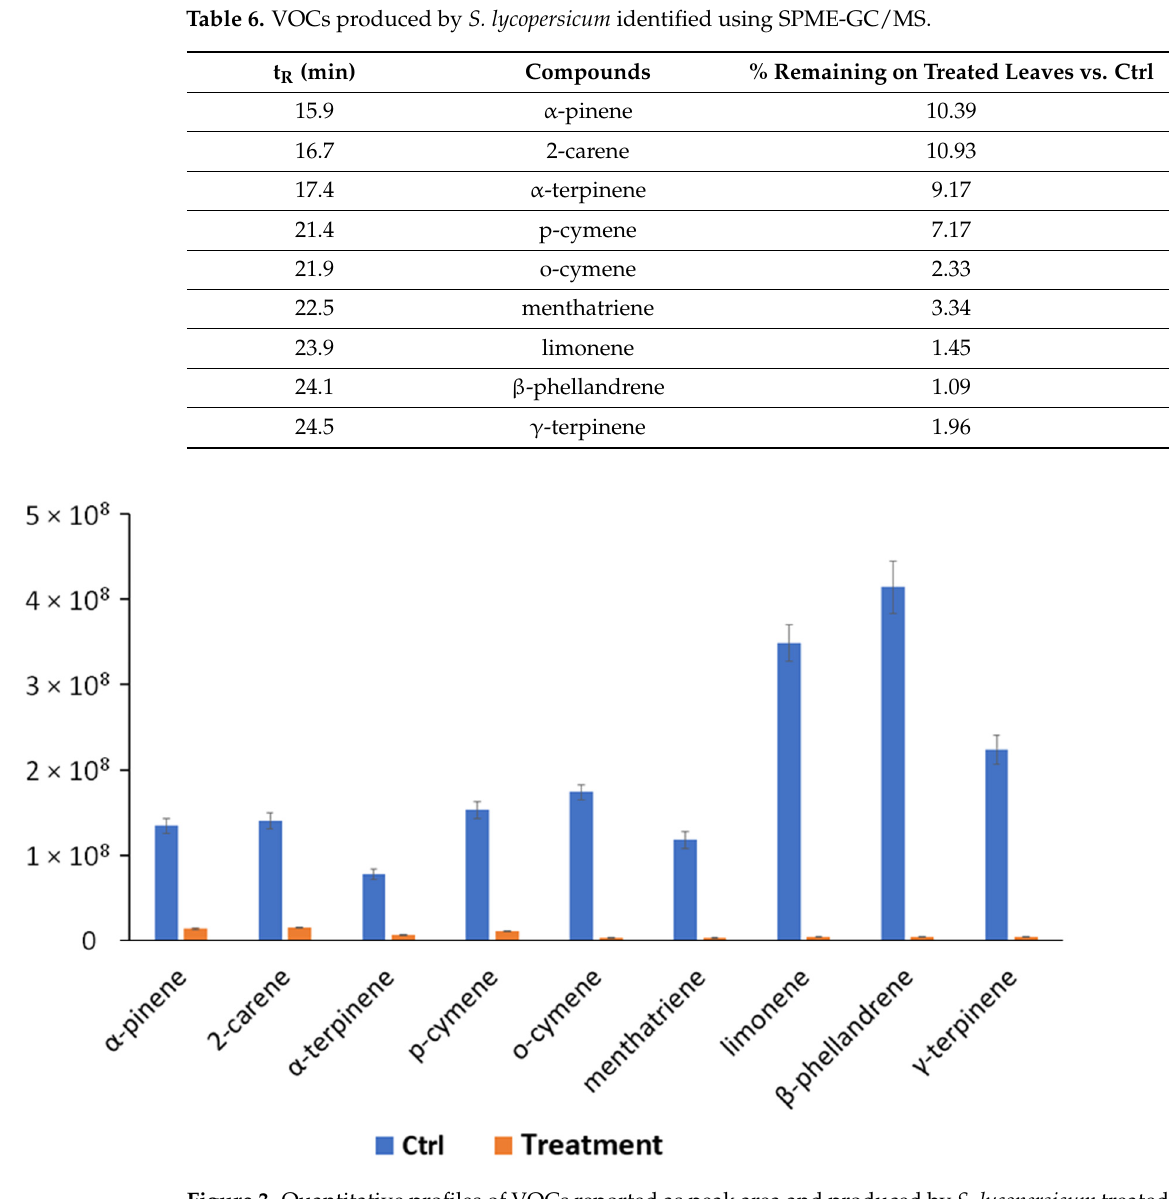
Figure 3. Quantitative profiles of VOCs reported as peak area and produced by S. lycopersicum treated (Treatment) and untreated (Ctrl, control condition) identified using SPME ‐ GC/MS. All quantitative group differences are statistically significant ( p < 0.05) according to the one ‐ way ANOVA test.